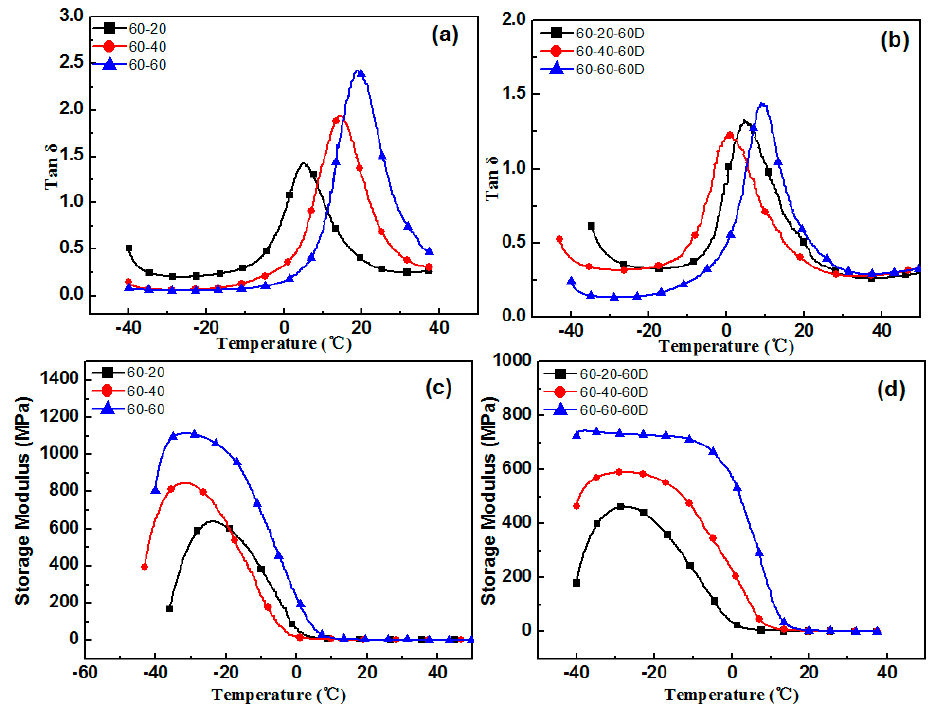
Figure 3. The effect of thermal aging on the storage modulus and tan δ of the XNBR/AO-60 blends: ( a ) tan δ of XNBR/AO-60; ( b ) tan δ of XNBR/AO-60 after aging; ( c ) the storage modulus of XNBR/AO-60; ( d ) the storage modulus of XNBR/AO-60 after aging.